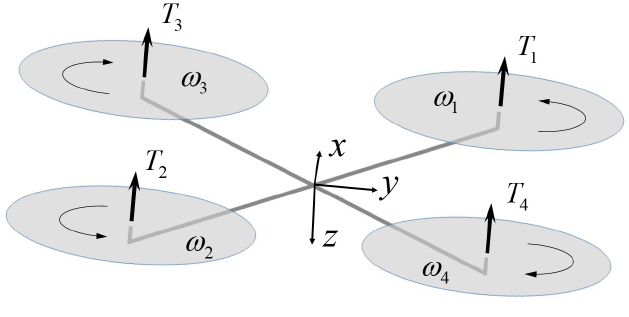
Figure 1. Body-fixed frame of the quadrotor and motor